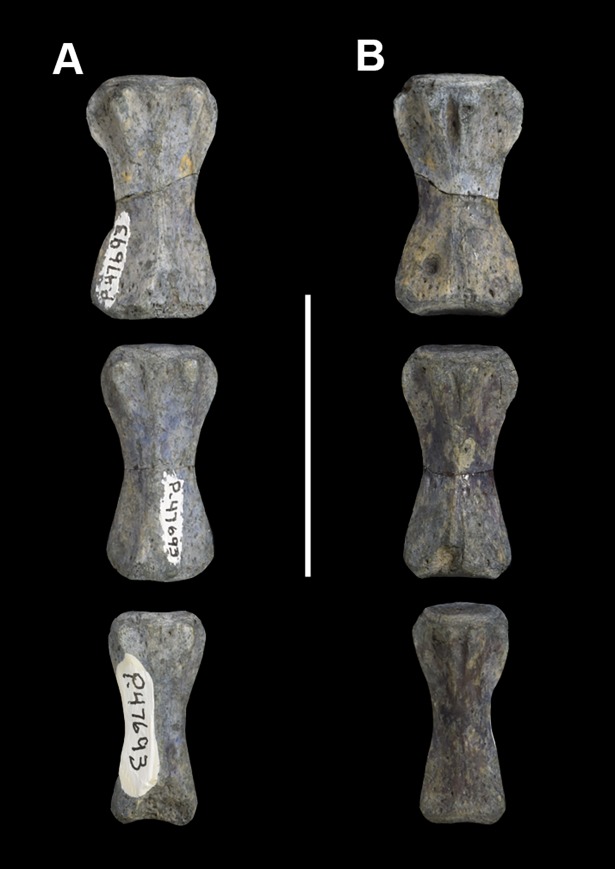
Caudal vertebrae of Periptychus carinidens (NMMNH P-47693).(A) dorsal view; (B) ventral view. Scale bar: 30mm.